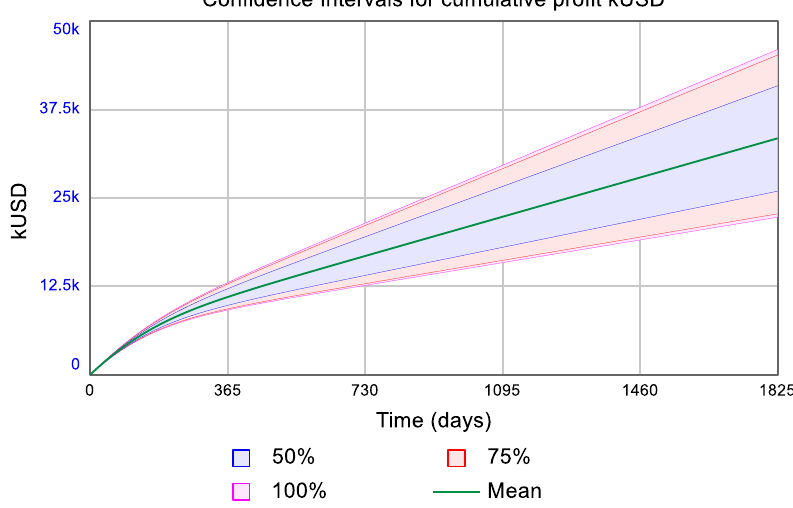
Figure 10. Cumulative profit over five years (1825 days) for different values of the time between two consecutive maintenance events. The mean value and confidence intervals are shown.